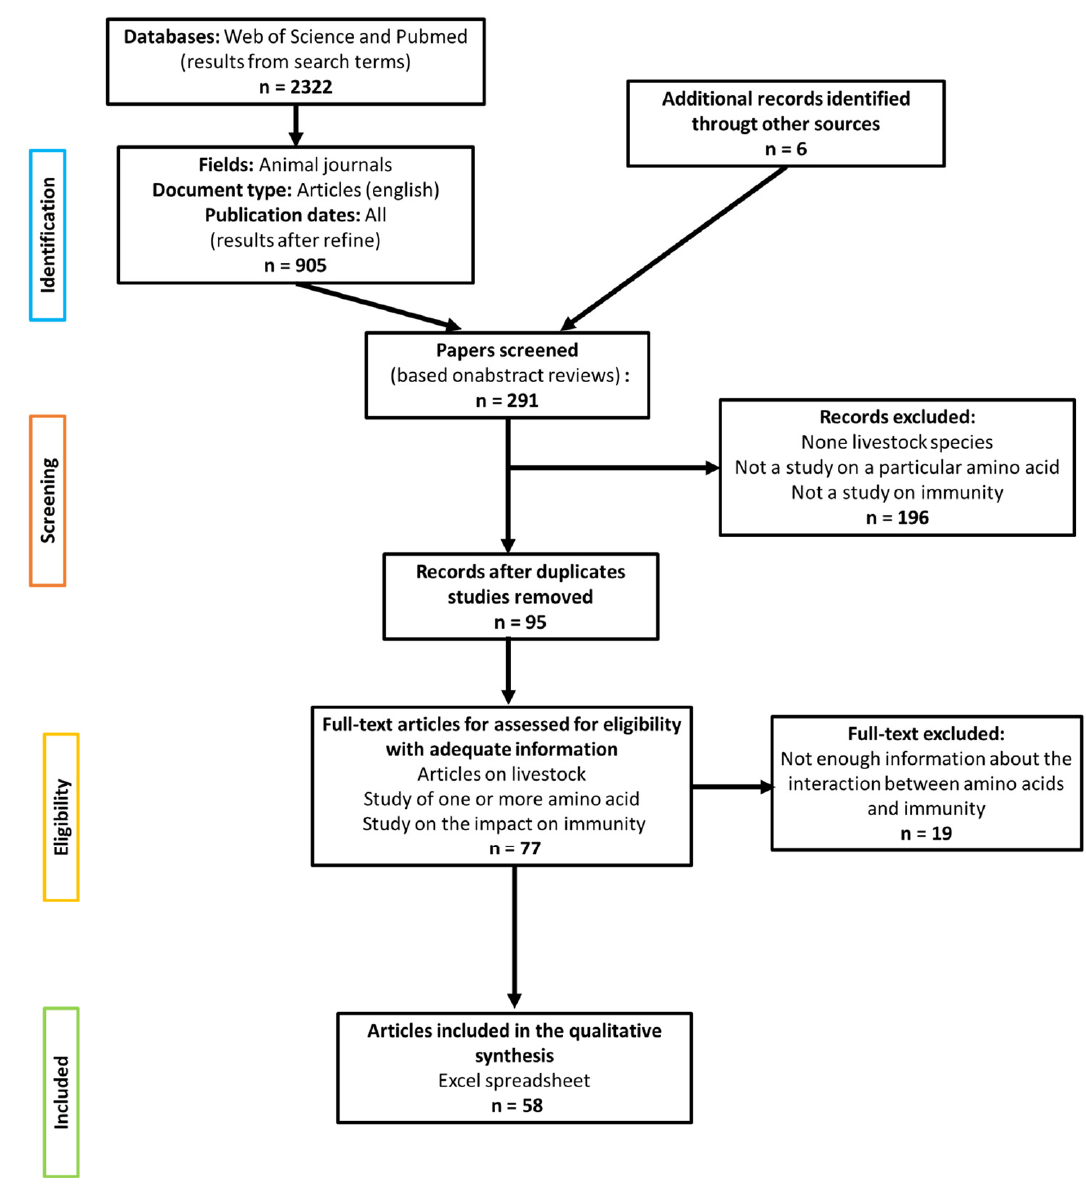
Figure 1. Search strategies: PRISMA Flow Diagram (2009). Flowchart describing the methods of data collection and article selection. Table 1. Search terms used for the systematic review.